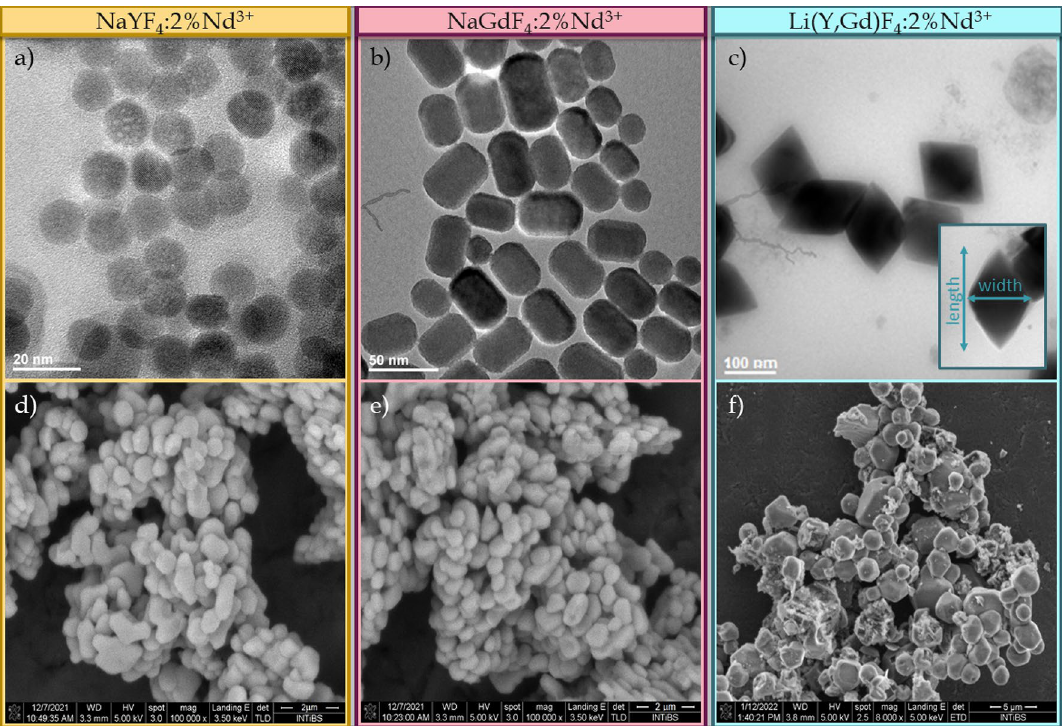
Figure 2. TEM images of β -NaYF 4 :Nd 3+ ( a ), β -NaGdF 4 :Nd 3+ ( b ) and LiGdF 4 :Nd 3+ ( c ) nanocrystals and SEM images of β -NaYF 4 :Nd 3+ ( d ), β -NaGdF 4 :Nd 3+ ( e ) and LiGdF 4 :Nd 3+ ( f )